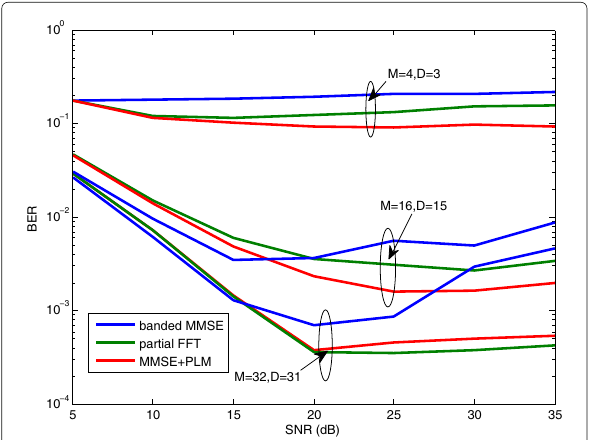
Fig. 7 BER performance against SNR, N s = 512, F d T s =